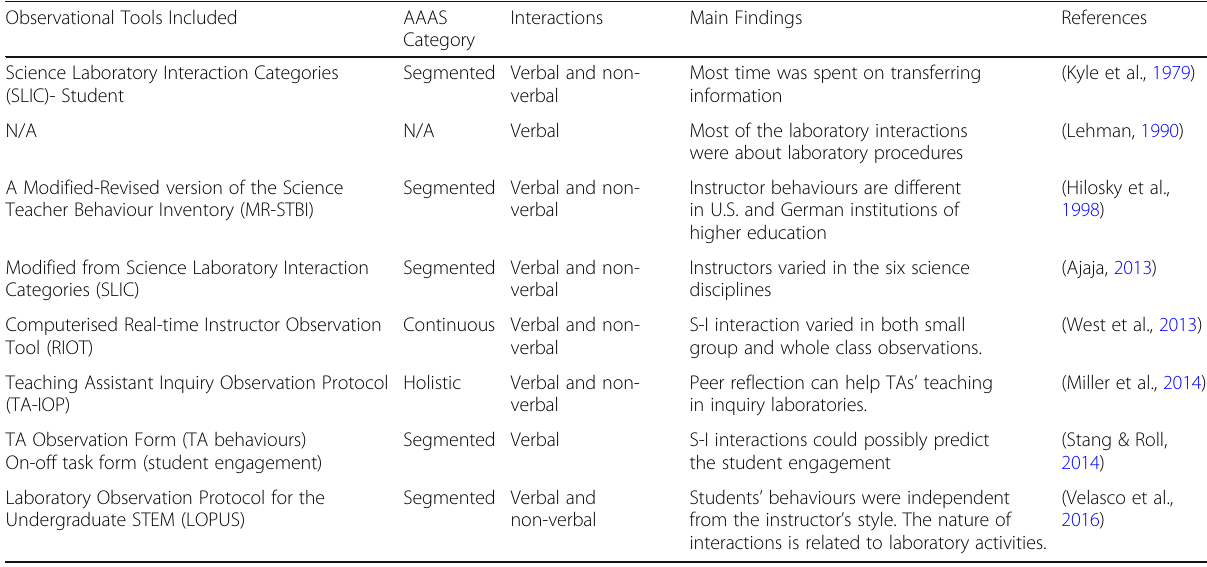
Table 1 The name and category of observation tools, types of interaction and main findings in face-to-face science undergraduate